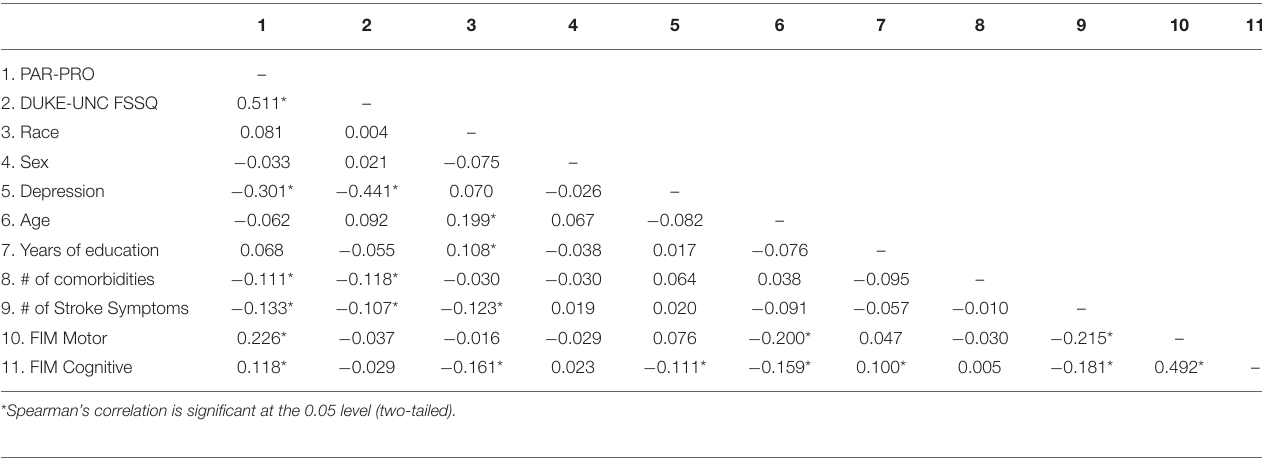
TABLE 3 | Hierarchical regression